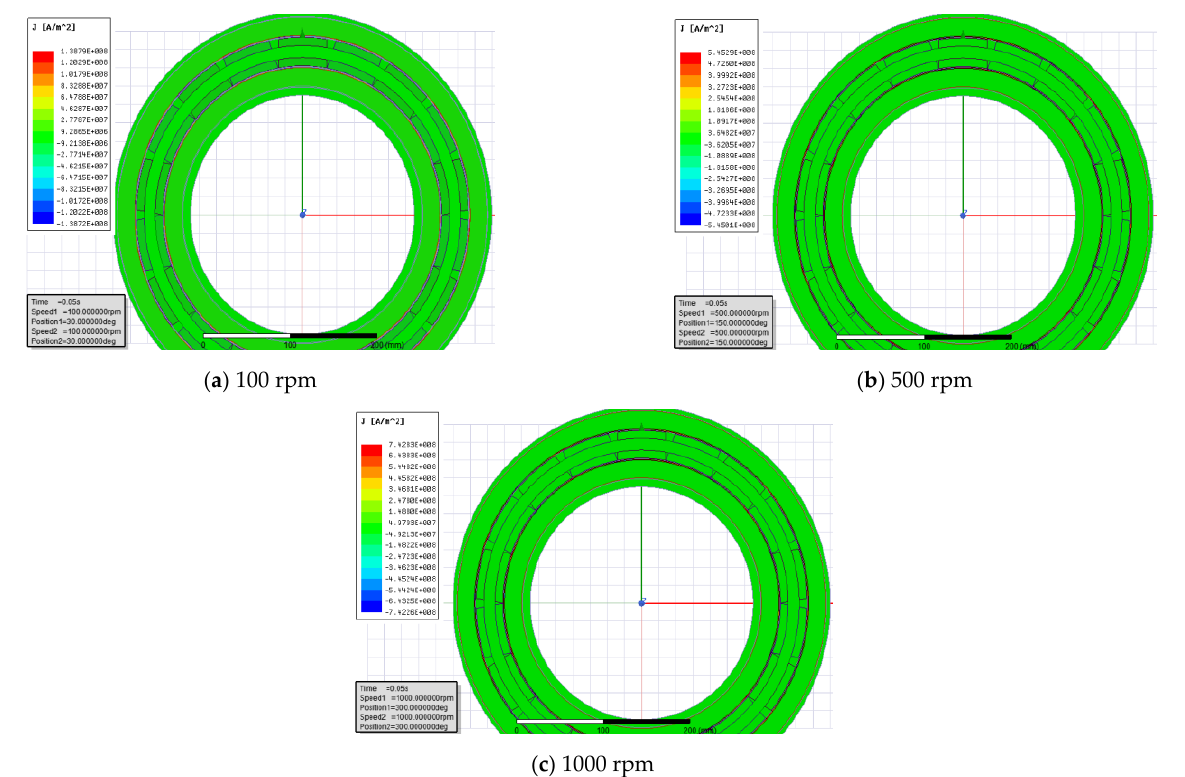
Figure 14. Cloud diagram of eddy current density distribution at different speeds.